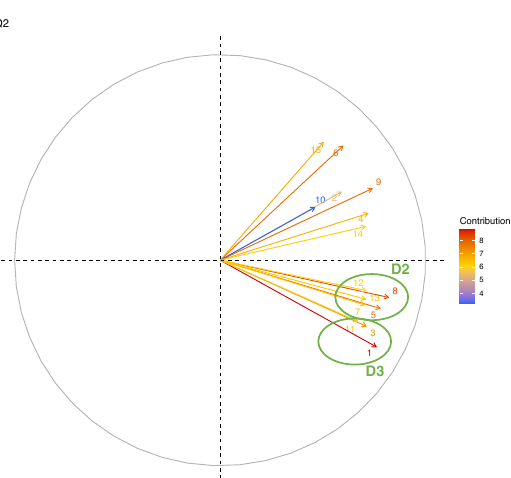
Figure 2. Principal component analysis of the work-related stress sections of the questionnaires. Each arrow represents a different question. The green circles highlight the identified